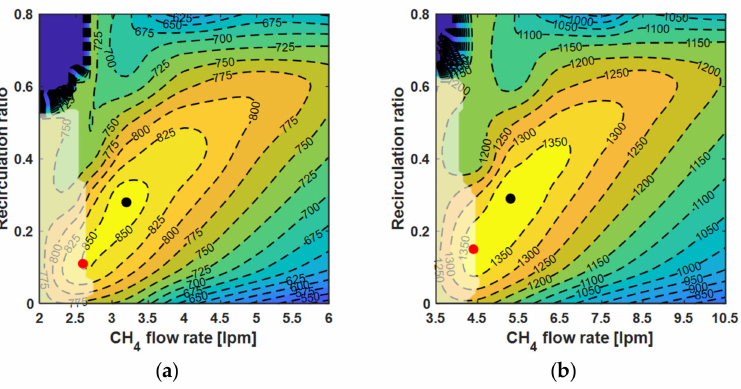
Figure 6. Change in net power with various fuel flow rates and recirculation ratios at operating current densities of ( a ) 0.3 A/cm 2 and ( b ) 0.5 A/cm 2 . Table 7. Operating conditions and the system performances when net power became maximized in Figure